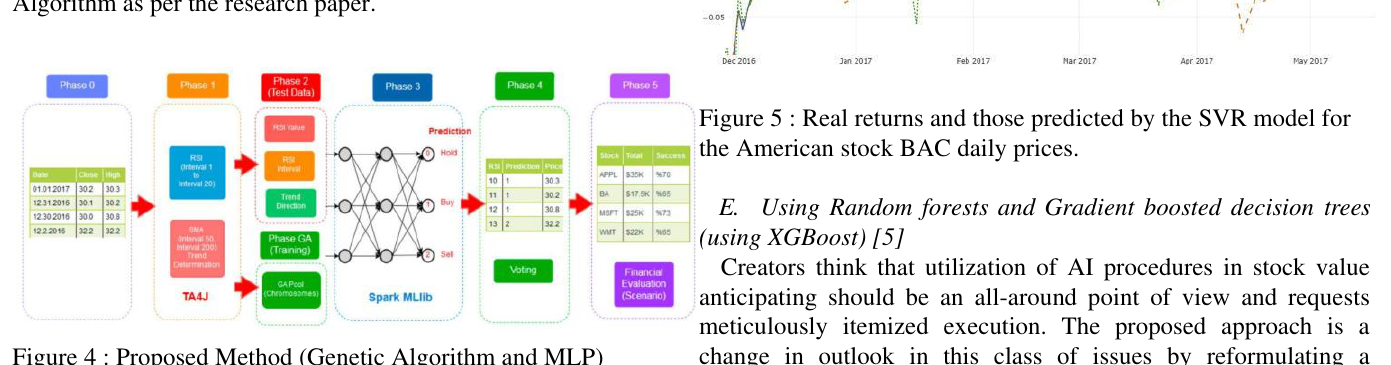
Figure 4 : Proposed Method (Genetic Algorithm and MLP) D. Using only Support vector Machine Regression (SVR) [6]